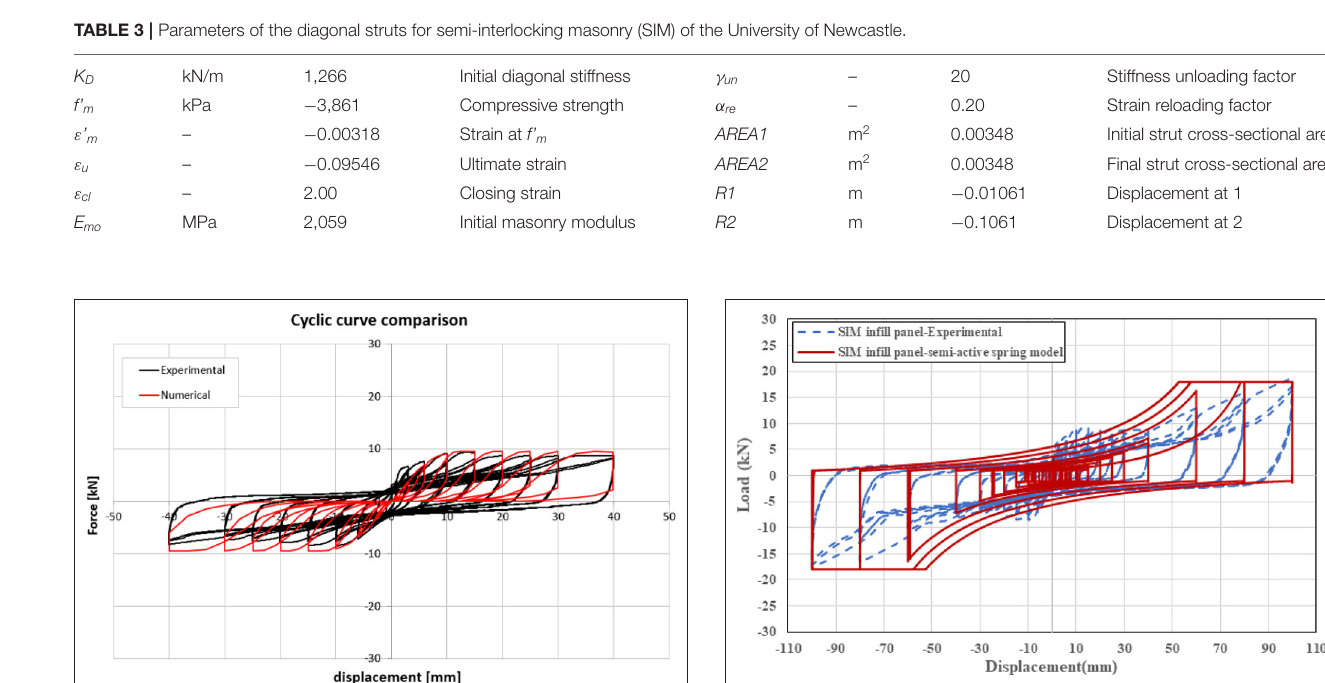
TABLE 4 | Parameters of the semi-active spring model for semi-interlocking masonry (SIM) infill